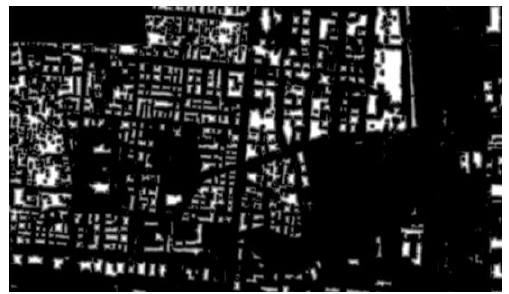
Figure 2 . 4 : Distance transform output